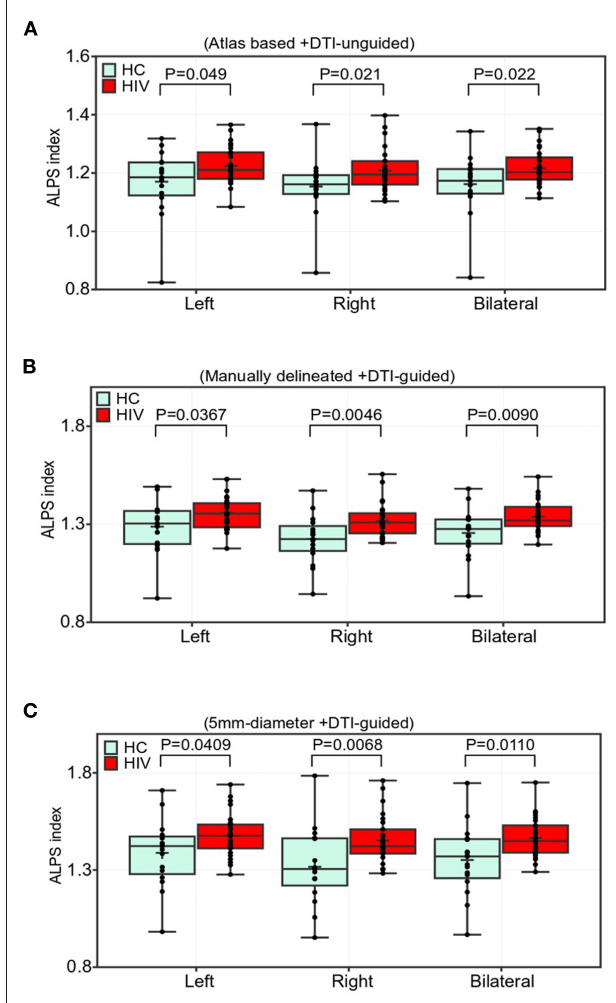
FIGURE 3 | Comparisons of the ALPS indexes in the periventricular white matter (PVWM) veins between the HIV and HC groups. Two sample t -test with false discovery rate correction was used (FDR, p < 0.05). The group differences were based on (A) atlas-based approach, i.e., using labels from JHU-ICBM DTI-atlas and manual approaches using, (B) manually delineated regions of the lateral PVWM areas with reference to color-coded FA map, and (C) using 5-mm-diameter spherical ROIs. Participants in the cART-treated HIV group showed a significantly higher ALPS index than those in the HC group (A–C) . Boxes indicate the 25th − 75th percentiles of the ALPS index, and the lines and whiskers show the median and range of the ALPS index,